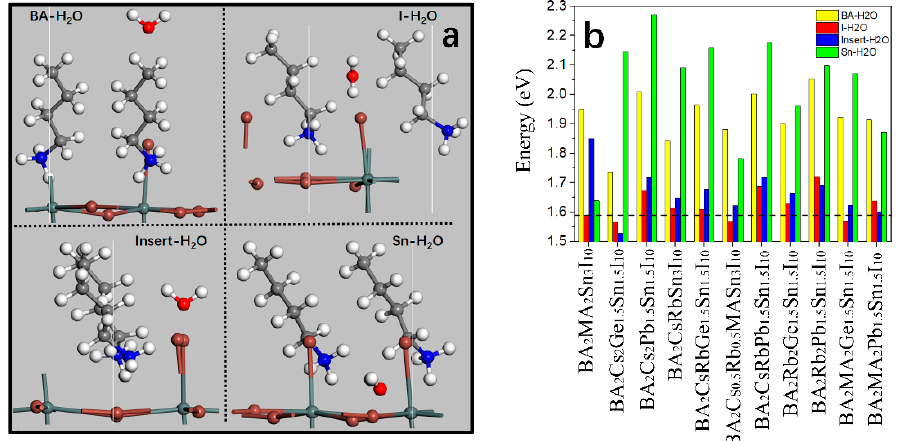
Figure 7. ( a ) Adsorption sites of water molecules. ( b ) Adsorption energies of water molecule for the various atoms (Cs, Rb, Ge, and Pb) mixed 2D SnI-based systems. The dashed line in ( b ) indicates the lowest H 2 O-adsorption energy on the pure 2D SnI-based system.